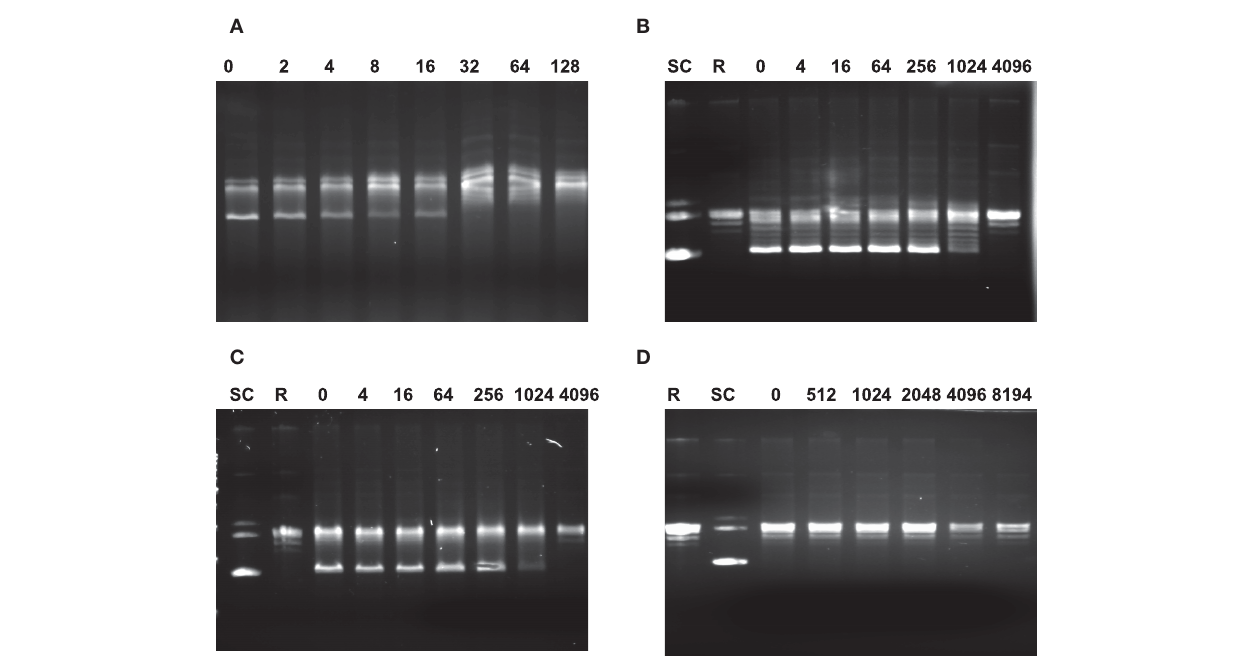
GyrB; (C) reactions with mutant GyrA (Asp-90-Asn) and GyrB; and (D) reactions with mutant GyrA (Thr-86-Ile) + GyrB.The numbers on top of each panel are the concentrations of ciprofloxacin ( μ g/ml) used in the reaction. SC indicates supercoiled DNA and R represents relaxed DNA (TopoGen). In each lane, the most supercoiled band migrates faster than the other